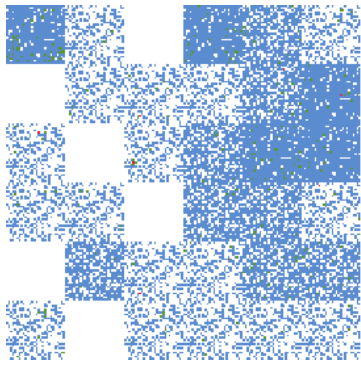
Figure 1: Structure and distribution of neighborhood of different